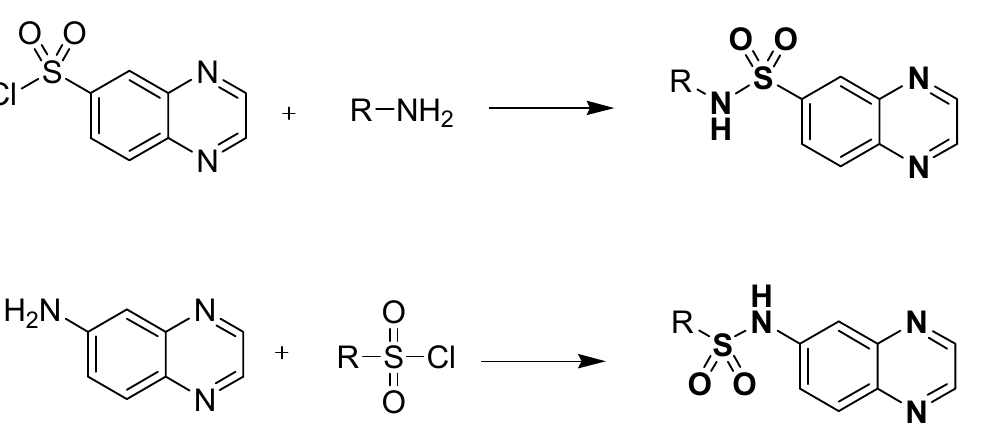
Figure 6. General preparation of quinoxaline sulfonamides.